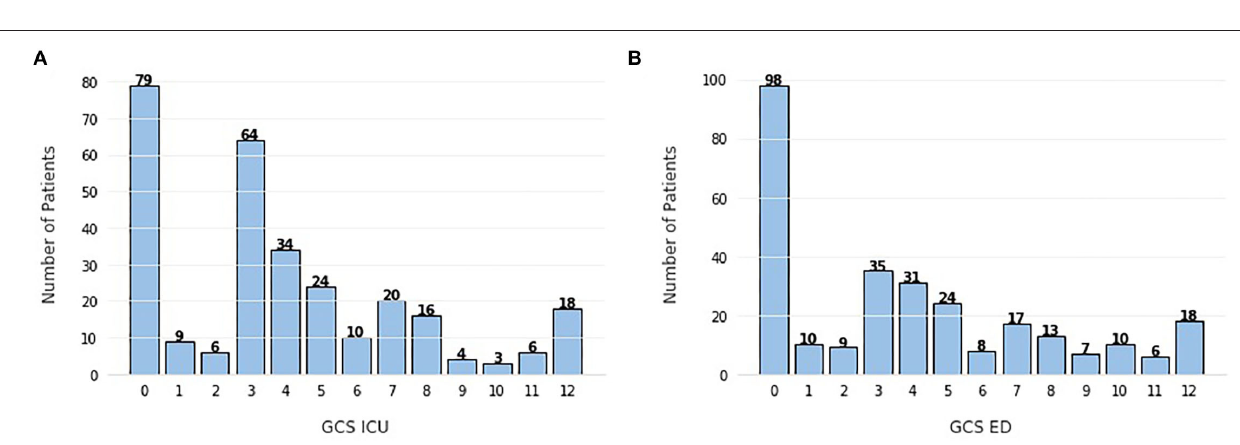
FIGURE 6 | Ten most important features according to Gini feature importance computed by XGBoost.